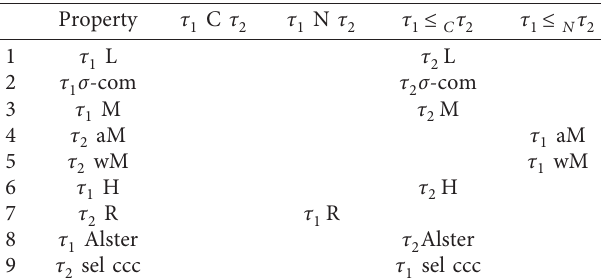
Table 1: The preservation of some covering properties under various